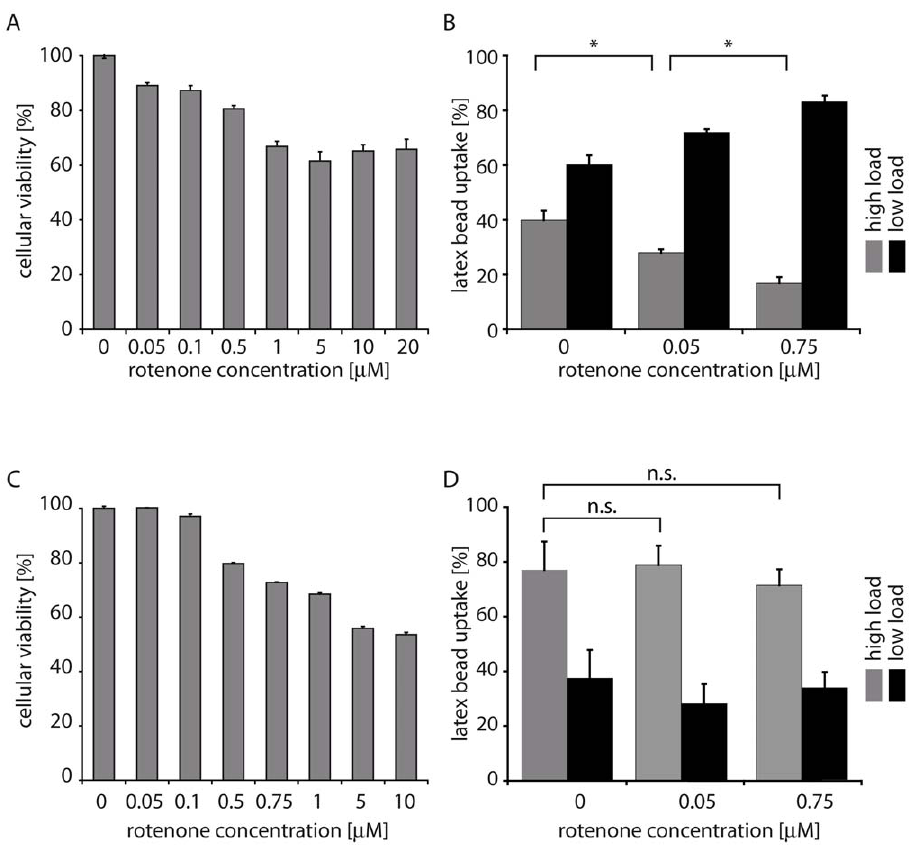
Figure 4. Oxidative stress impairs MEC function. Ben-Men-I cells (A; error bars represent + SEM; ANOVA p , 0.01, Tukey’s HSD post-hoc test see Figure S1A) (5 6 10 4 cells/ml) or PMECs (C; error bars represent + SEM; ANOVA p , 0.01, Tukey’s HSD post-hoc test see Figure S1B) were treated with varying concentrations of the complex I inhibitor rotenone (0–20 m M) for 24 hours to induce oxidative stress. Oxidative damage resulting in decreased viability was measured using MTS. The impact of oxidative stress on MEC function in terms of endocytosis was analyzed by scoring fluorescent latex bead uptake following treatment with different concentrations (0, 0.05 and 0.75 m M) of rotenone. Intensity of latex beads engulfed by Ben-Men-I cells (B; . 100 cells/condition; error bars represent SD of three independent counts; Student’s t-test: p , 0.05; marked with * for significant) or PMECs (D; . 100 cells/condition; error bars represent SD of three independent counts; Student’s t-test: p . 0.05; marked with n.s. for not significant) decreases with increasing of rotenone concentration where Ben-Men-I cells display a high sensitivity towards rotenone with a reduction in endocytosis at low, non toxic rotenone concentrations while PMECs are more resistant to oxidative stress and maintain their rate of endocytosis.